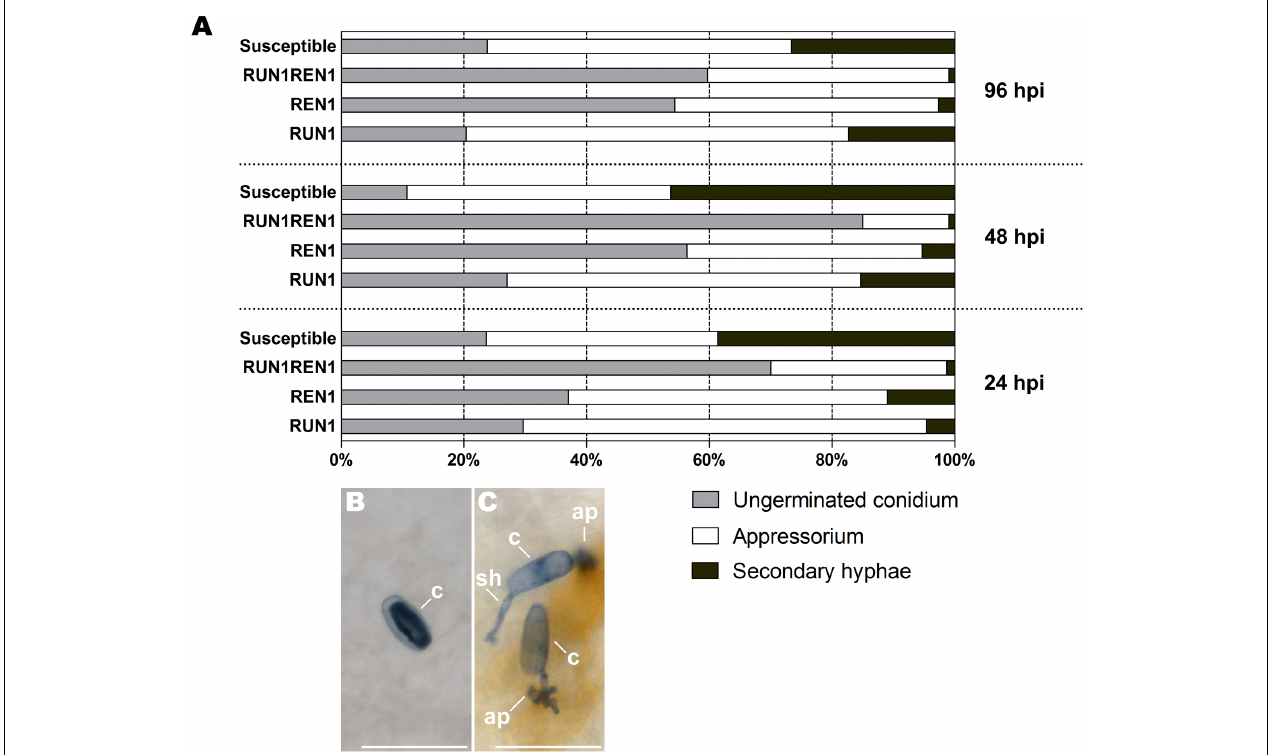
FIGURE 3 | Development of E. necator in leaves of resistant grapevine genotypes carrying RUN1 and/or REN1 loci. (A) Frequency of ungerminated conidia, penetration attempts leading to appressorium formation but unsuccessful penetration, and penetration attempts leading to successful penetration with secondary hypha development at 24, 48, and 96 hours post-inoculation (hpi). Each data point was calculated from three biological replicates by scoring a minimum of 100 inoculated conidia per leaf disk. Conidia were scored in different inoculated leaf samples per each infection time. (B) Ungerminated conidia; (C) germinated conidia exhibiting successful (top) and restricted (bottom) penetration. c, conidium; ap, appressorium; sh, secondary hypha; scale bar, 50 µ